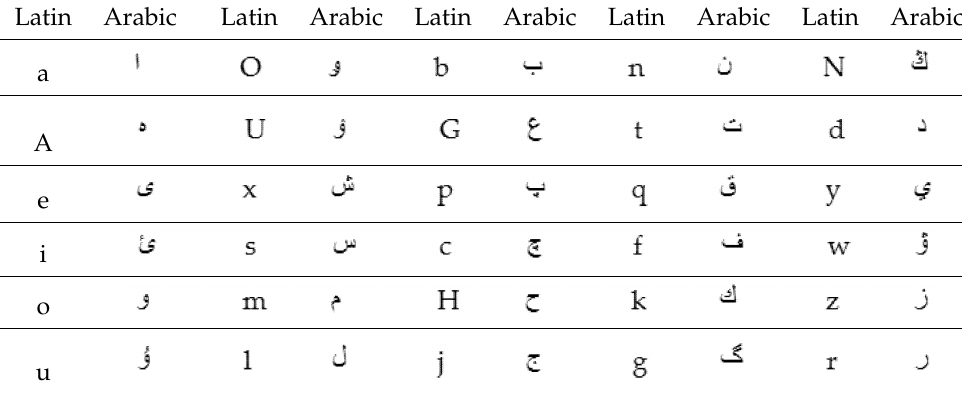
Table 6. Arabic and Latin alphabet for Kirghiz.